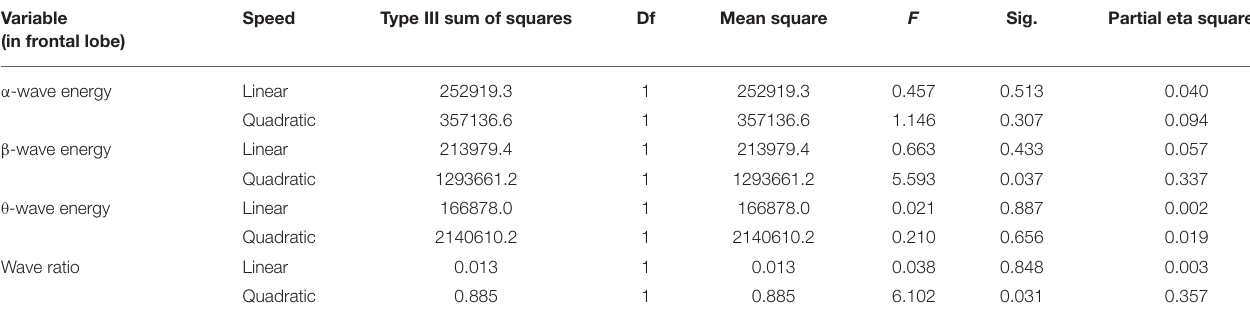
TABLE 4 | Tests of within-subject